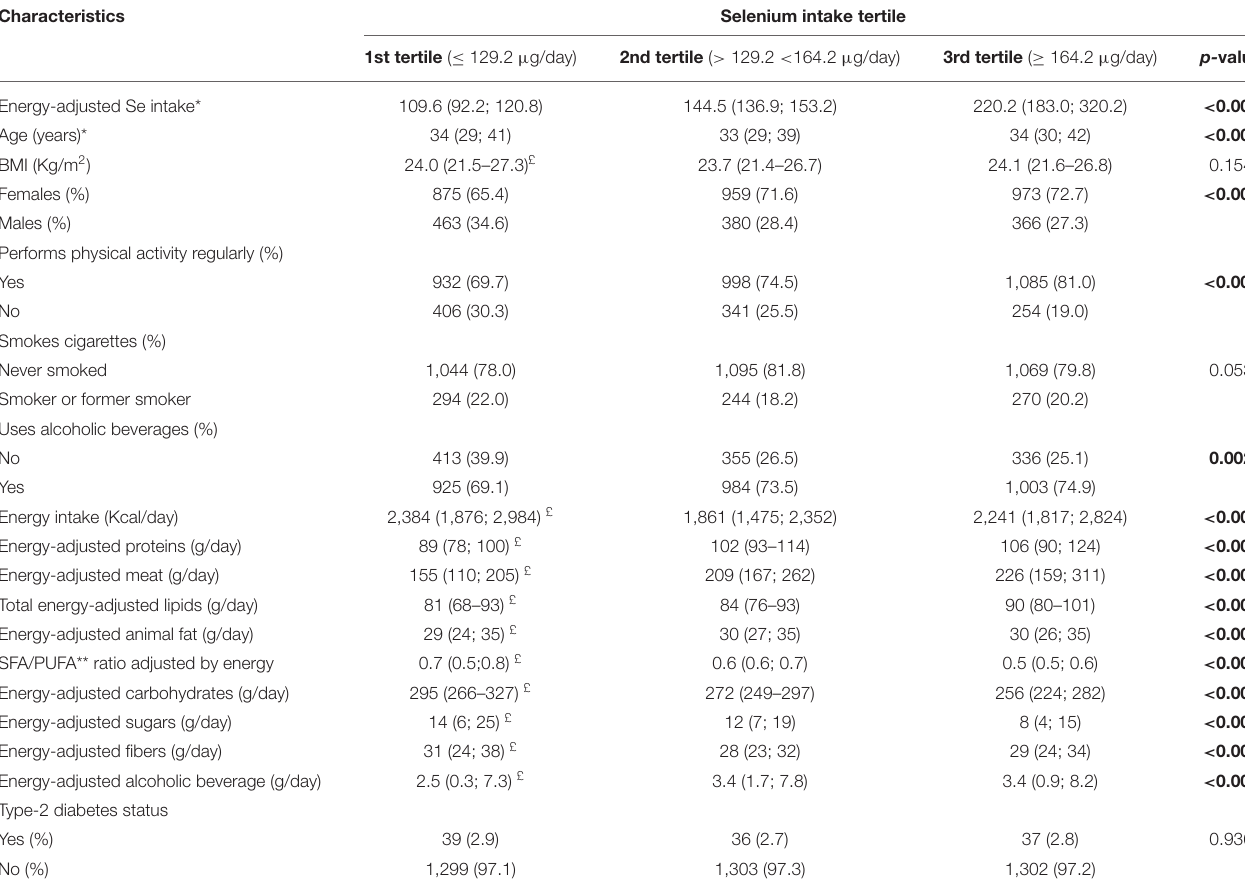
TABLE 2 | Characteristics of the study population according to dietary selenium intake ( n = 4,016).